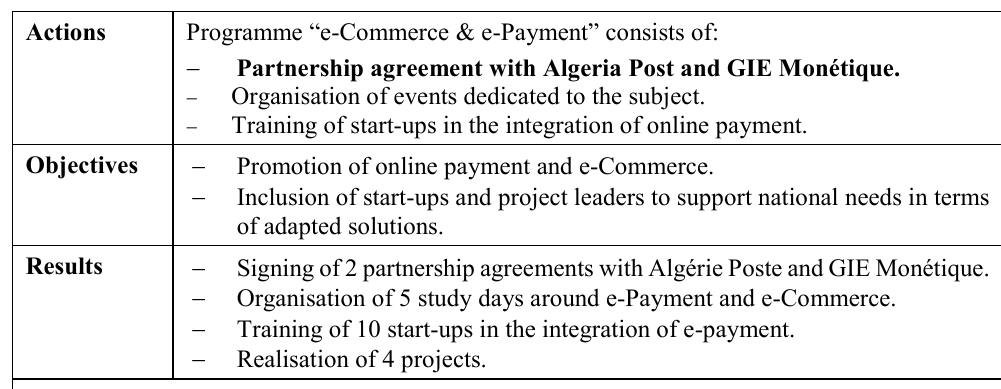
Table 4. Objectives, Actions and Results of the Year